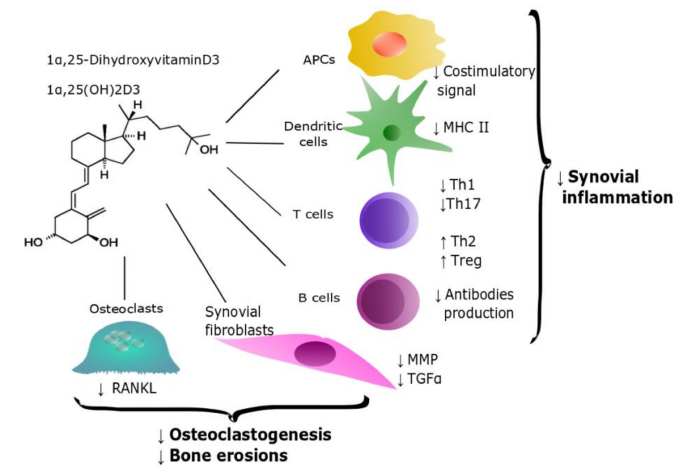
Figure 1. Scheme of 1 α ,25(OH)2D3 role in regulating immune response. As reviewed, it interacts both with innate- and adaptive-immune cells and with resident synoviocytes as well as osteoclasts, resulting in a decrease of synovial inflammation and, finally, in bone erosion. Arrows are used to illustrate decreased ( ↓ ) or increased ( ↑ ) production of specific actions, cells or